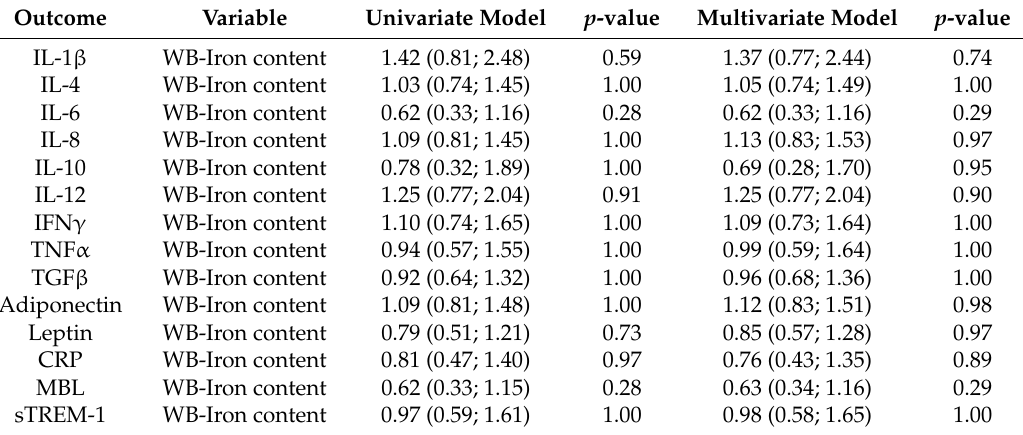
Table 3. Relative change in mean levels of cytokines, adipokines, and other proteins involved in the immune response with 95% confidence bands by 1 unit increase in neonatal whole blood iron content—results from models with correction for multiple